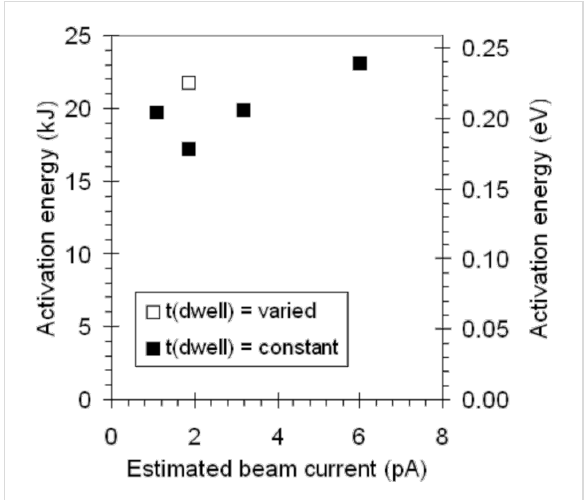
Figure 4: The activation energies for desorption calculated from the data in Figure 2b and Figure 3b.